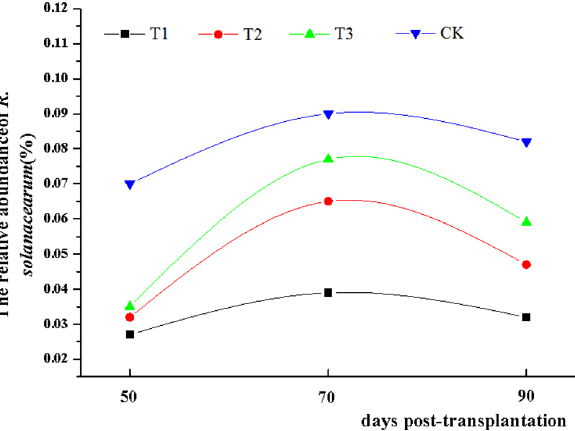
Figure 3. The relative abundance of R. solanacearum in rhizosphere soil from four treatments at 50 days, 70 days and 90 days post-transplanted, respectively. CK: the control group, T1: marigold powder mix with B. amyloliquefaciens ZM9 group, T2: B. amyloliquefaciens ZM9 group, T3: marigold powder.